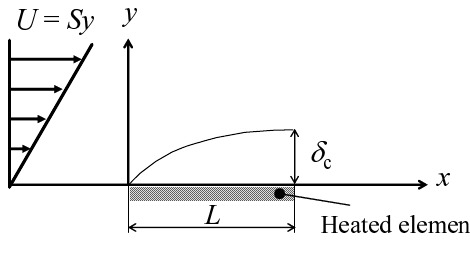
Fig. 5 Schematic view of the thermal boundary